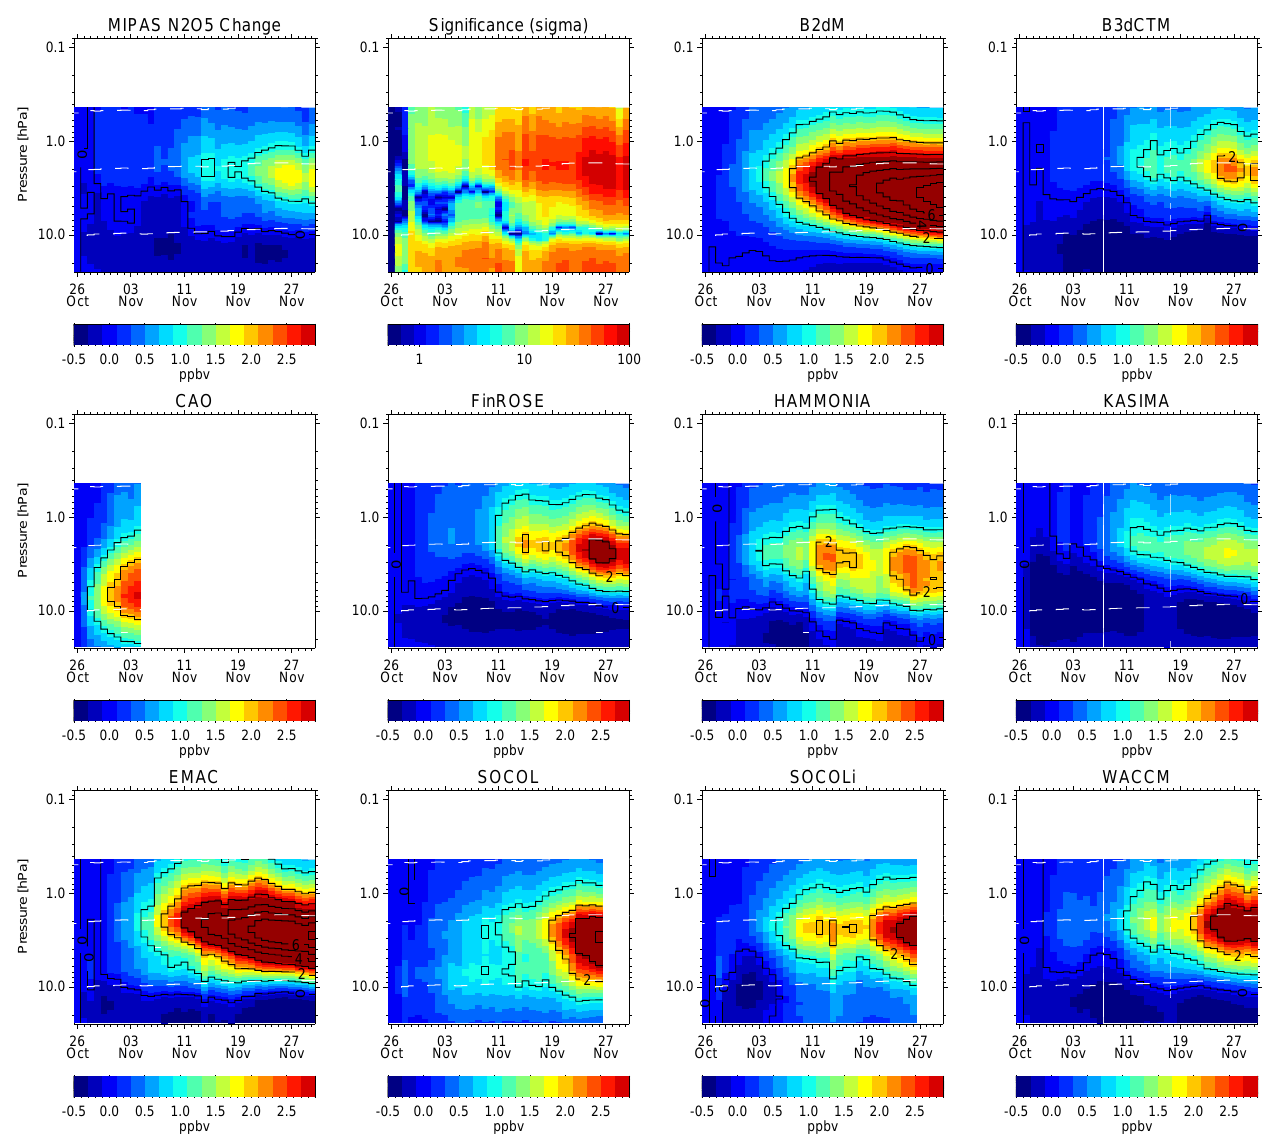
Fig. 21. Temporal evolution of area-weighted averages of N 2 O 5 changes with respect to 26 October 2003 in MIPAS observations and model simulations at 70–90 ◦ N. Solid contour lines reflect 1ppbv steps. The significance of observed N 2 O 5 changes (in units of σ ) is shown in the upper second panel (from the left).